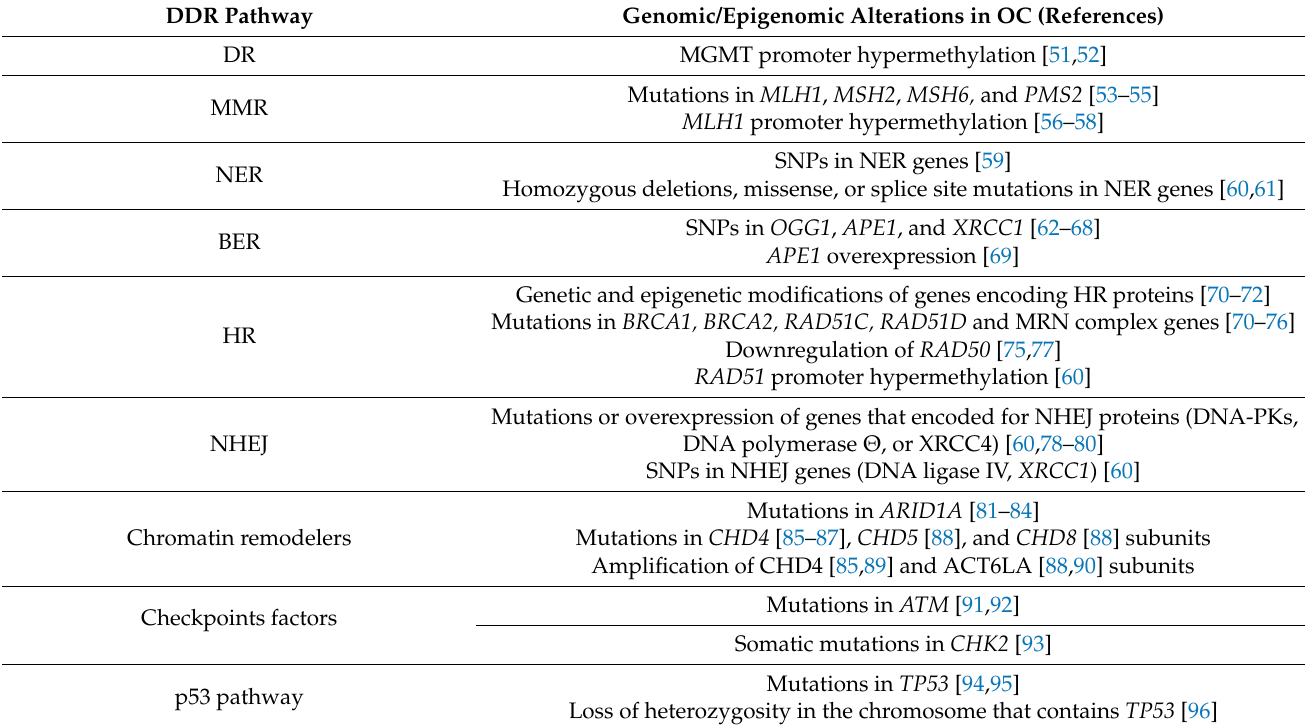
Table 3. DDR alterations in OCs.